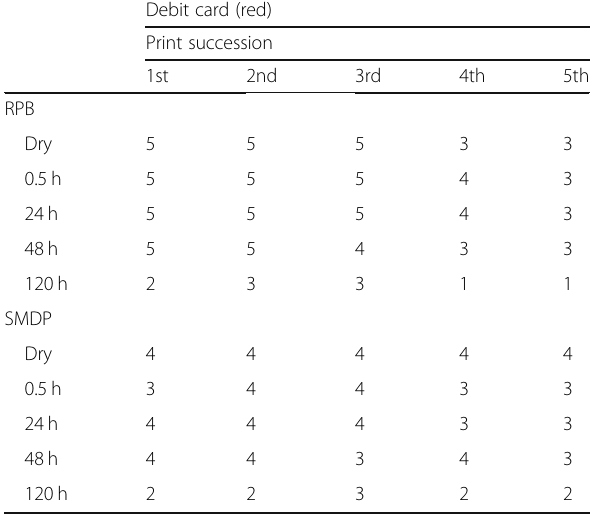
Table 8 Development of submerged and successive prints on painted iron saw using Robin powder blue and Silver magnetic dual